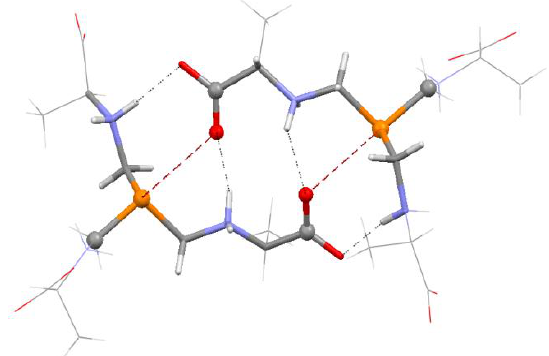
Figure 5. Fragment of crystal structure of tris( L -alanylmethyl)phosphine tetrahydrate. Colors: red = oxygen, orange = phosphorus, blue = nitrogen, white = hydrogen, gray = carbon. Dashed lines show P---O=C σ-hole interactions and N–H---O hydrogen